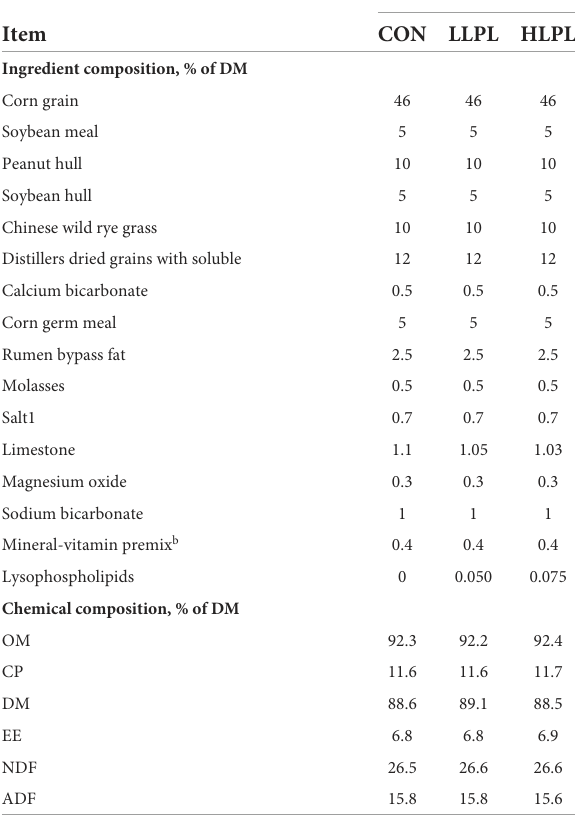
TABLE 1 Ingredients and chemical composition of the experimental diet (DM basis).